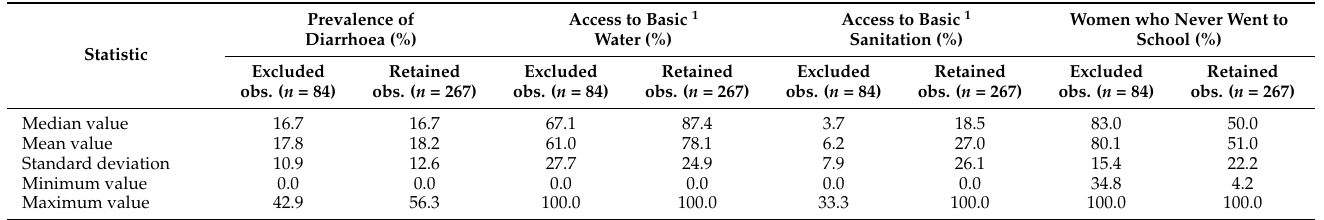
Table A1. General characteristics of the excluded and retained spatial units (obtained from DHS data).